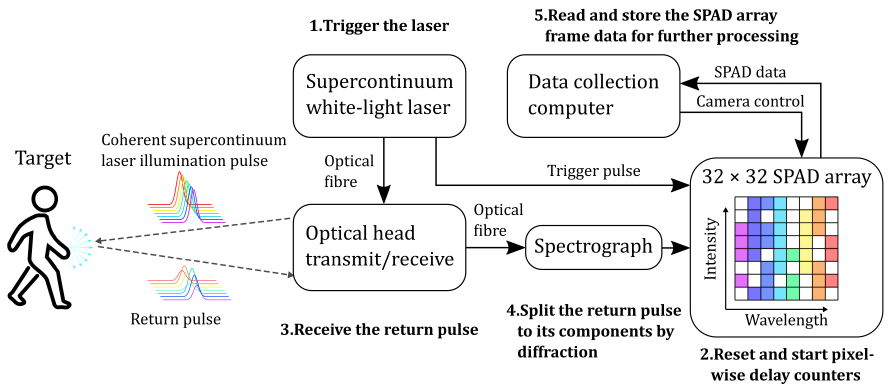
Figure 3. Operational block diagram of the hyperspectral single photon